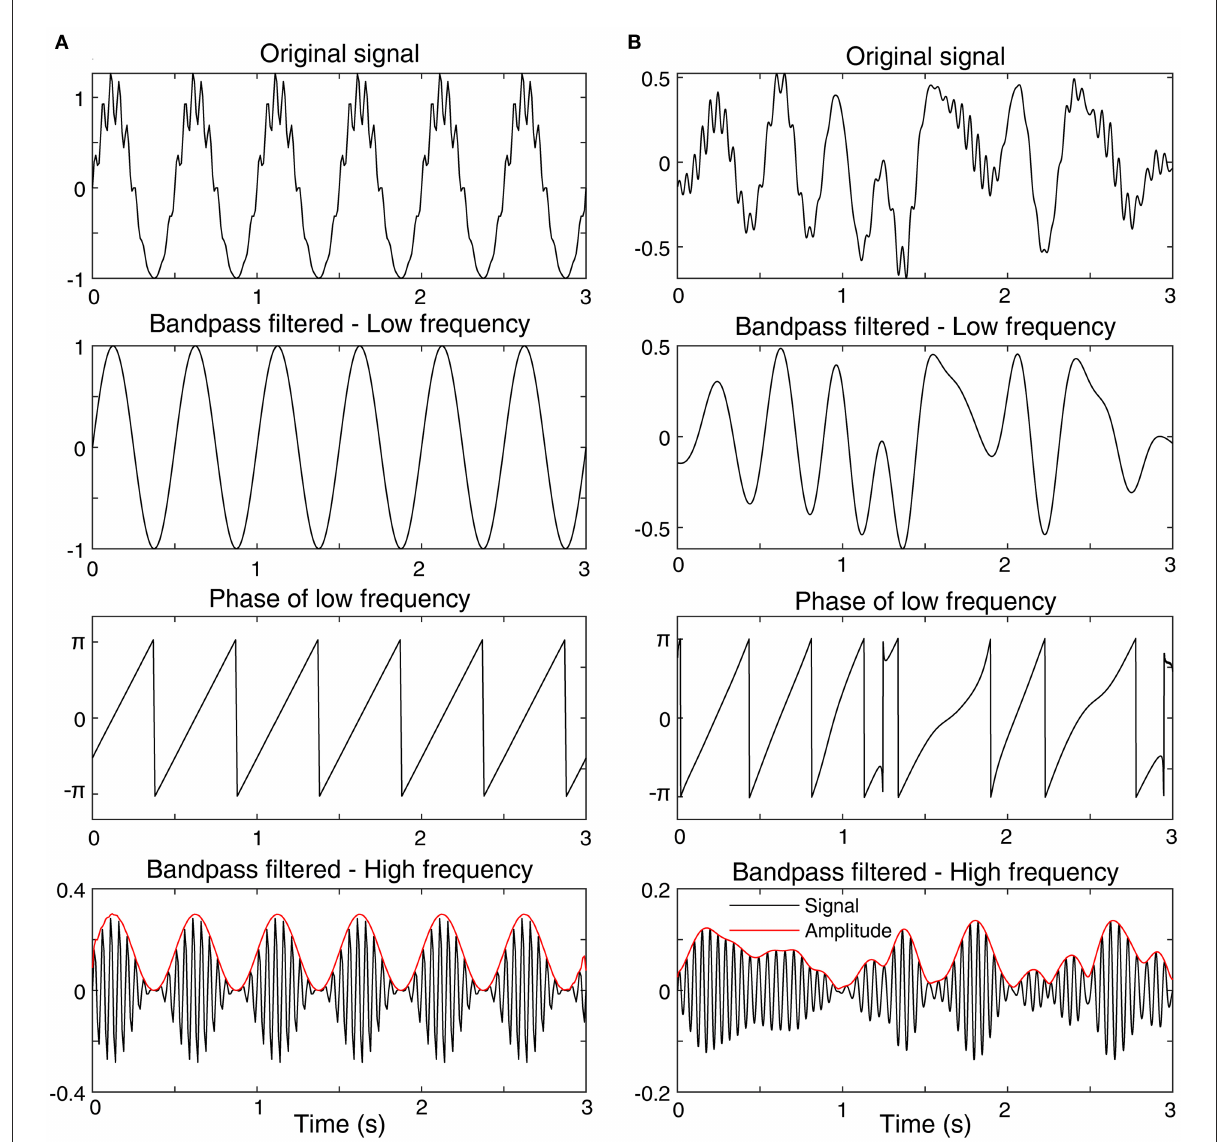
FIGURE6 Examples of phase-amplitude coupling. (A) A signal with high phase-amplitude coupling. (B) A signal with low phase-amplitude coupling. Each subfigure shows the original signal (top), the bandpass filtered signal in a low frequency band (2nd from top), the phase of the low frequency bandpass filtered signal (3rd from top), and the bandpass filtered signal in a high frequency band (bottom). The amplitude envelope of the high frequency signal is also shown (bottom, red). In subfigure (A) the bursts of high amplitude, high frequency activity always occur at the peak of the low frequency signal, represented by a phase of zero. This consistent relationship will lead to a high value of phase-amplitude coupling. In contrast, in subfigure (B) , the bursts of high frequency activity occur randomly with respect to the low-frequency phase, which will result in a low value of phase-amplitude